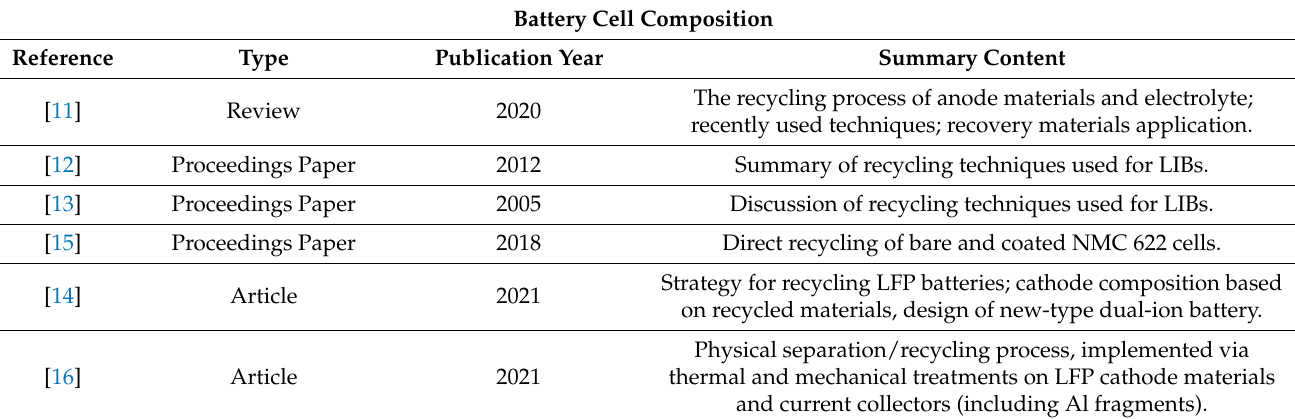
Table A1. Assessed literature in review for “Cathode”, “Anode“, and “Electrolyte“ category.